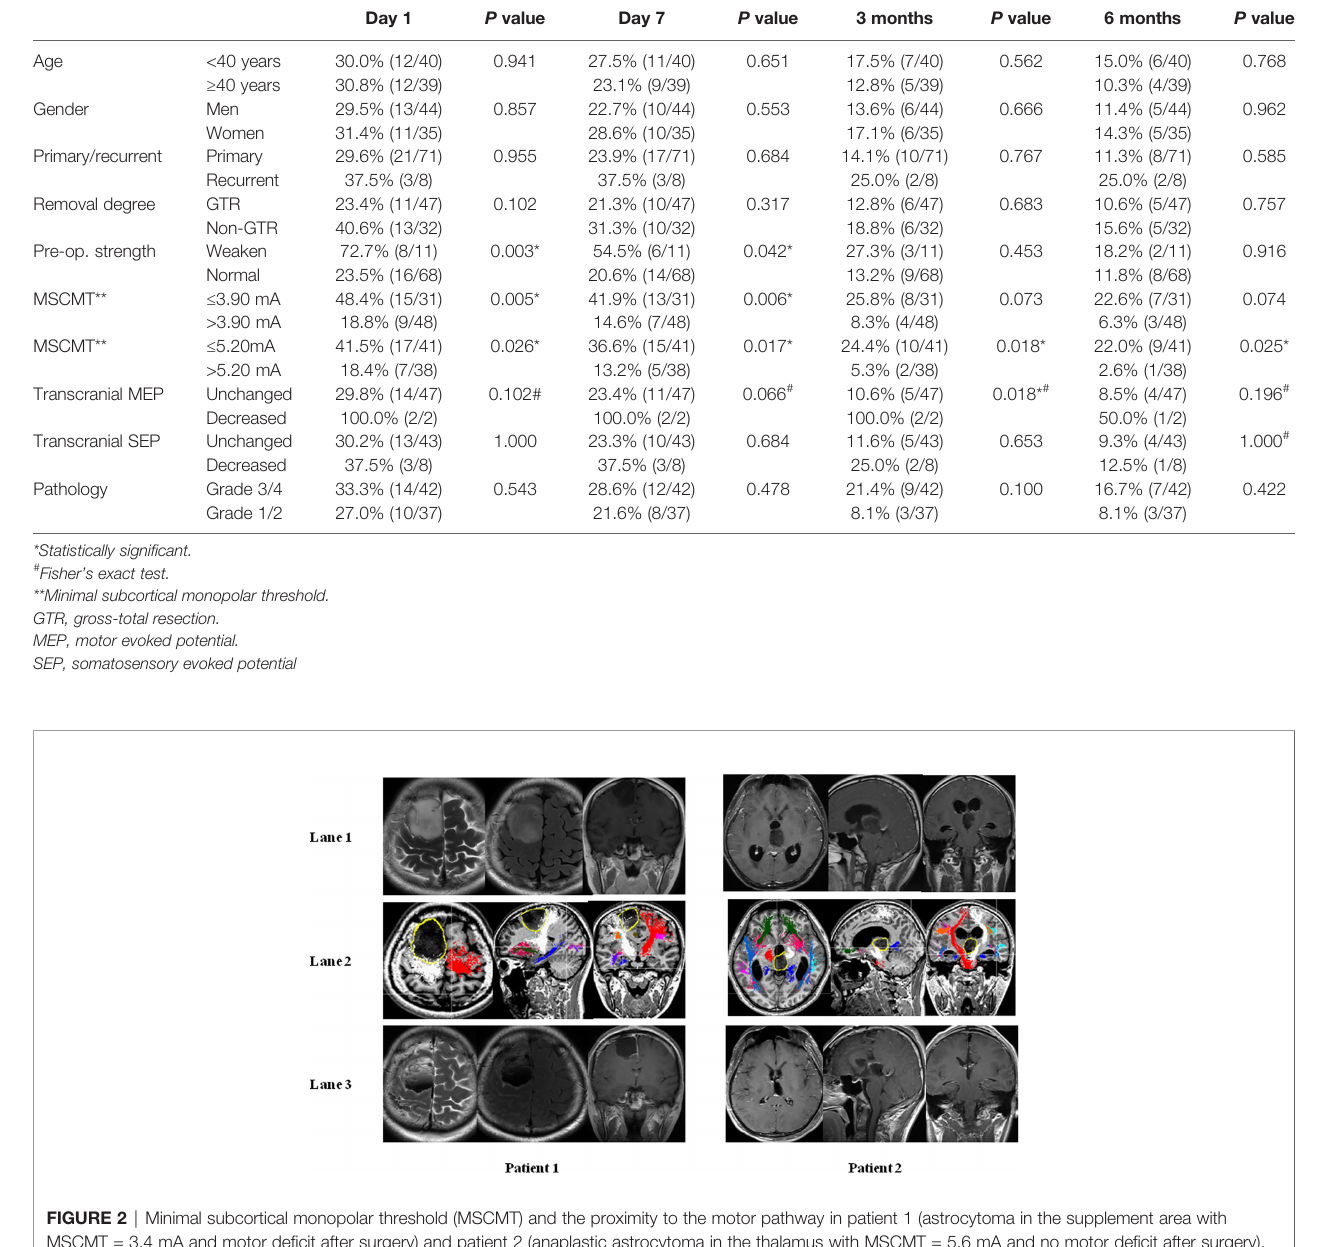
TABLE 1 | Factors correlated with postoperative motor de fi cit at different time points (n = 79). Factors Motor de fi cit after surgery